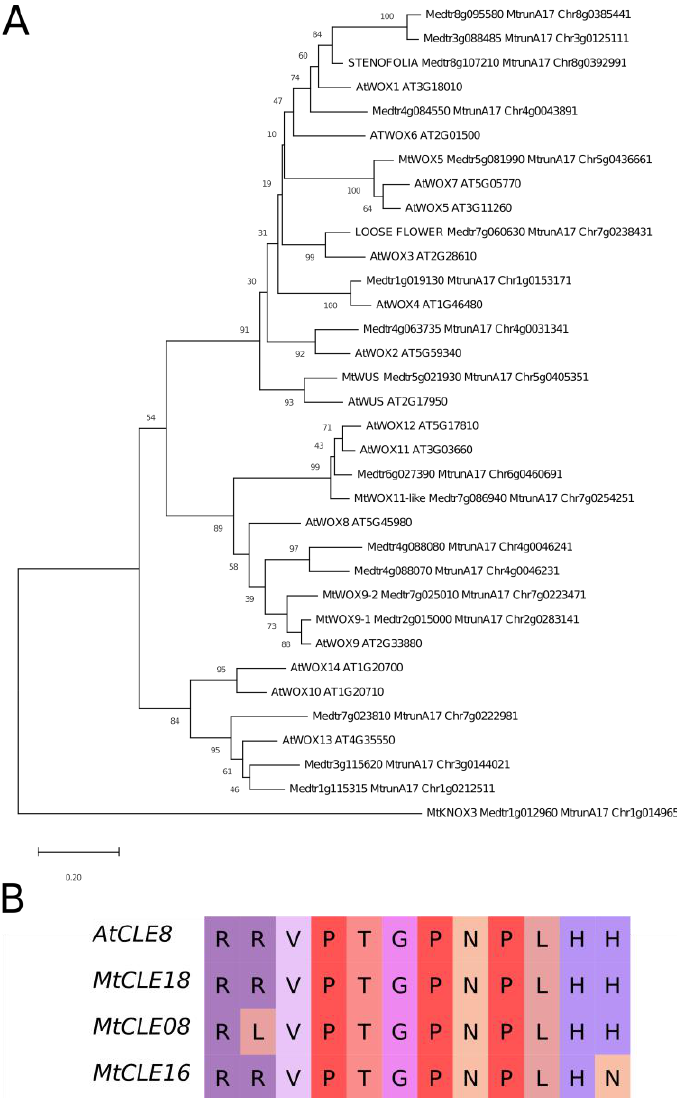
Figure 2. ( A ) Phylogenetic tree of A. thaliana and M. truncatula WOX proteins, based on homeodomain sequences. The tree was inferred using the Neighbor-Joining method [18]. The percentages of replicate trees in which the associated proteins are clustered together in the bootstrap test (500 replicates) are shown next to the branches [19]. The tree is drawn to scale, with branch lengths in the same units as those of the evolutionary distances used to infer the phylogenetic tree. Evolutionary analyses were conducted in MEGA X [20]; ( B ) Alignment of CLE domains of A. thaliana CLE8 peptide and M. truncatula MtCLE18, 08 and 16 peptides. Different colors represent different amino ac- ids.